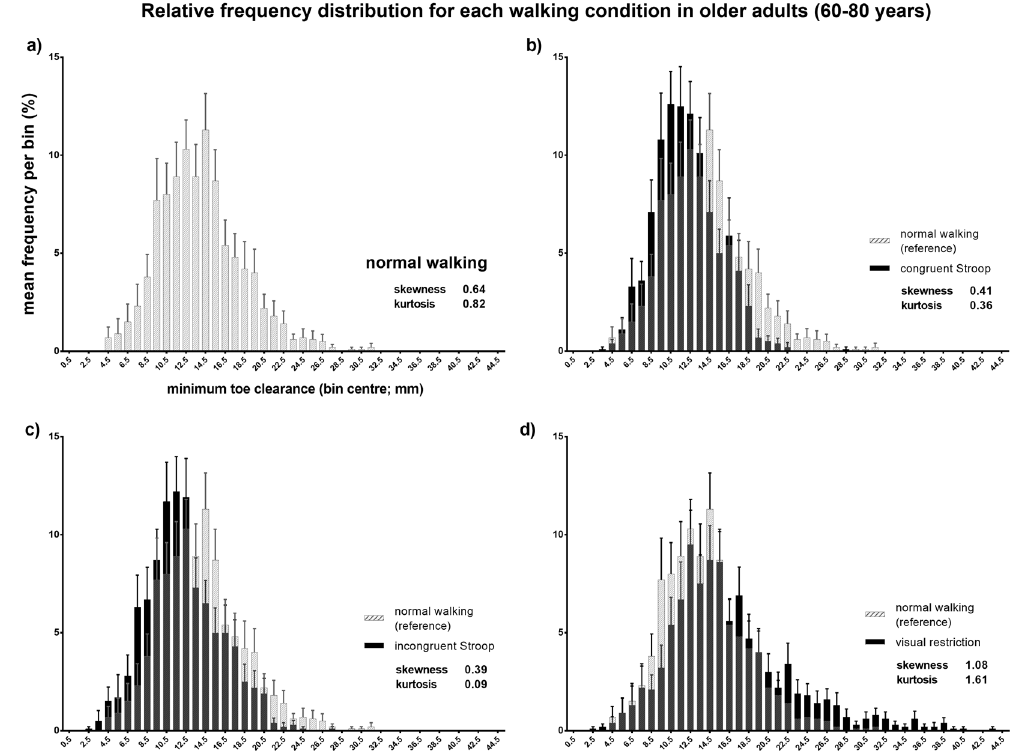
Figure 4. Relative MTC frequency distributions for healthy adults aged 60–80 years. Each individual contributed MTC values for 25 consecutive strides. Values indicated are mean frequencies per 1 mm bin with error bars indicating standard error of the mean. The histogram for normal walking is indicated in ( a ) and is presented as a semi-transparent overlay (grey) to allow comparison with the histograms of the three locomotor conditions (black; ( b – d) ). Similar graphics for the younger and middle-aged cohorts may be found in the Supplementary